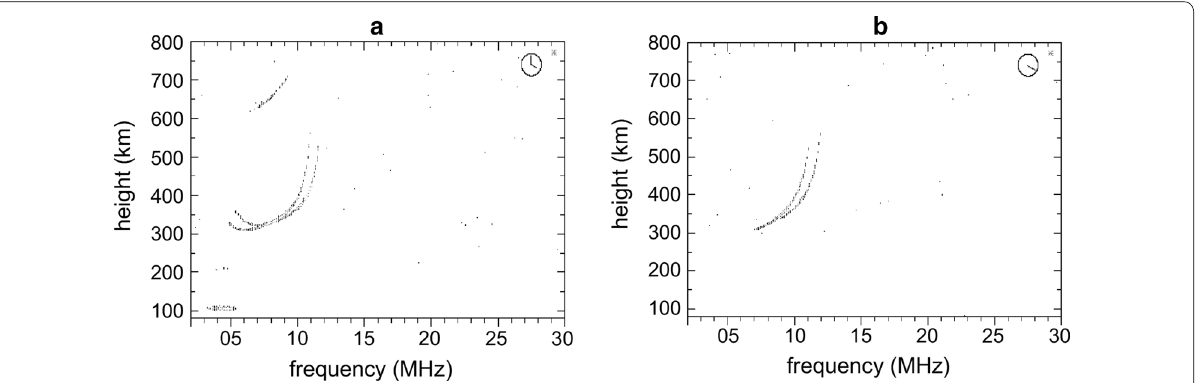
Fig. 9 Ionograms recorded in Taiwan on 25 June 2015 at a 08:00 UT (16:00 LT) and b 08:20 UT (16:20 LT)